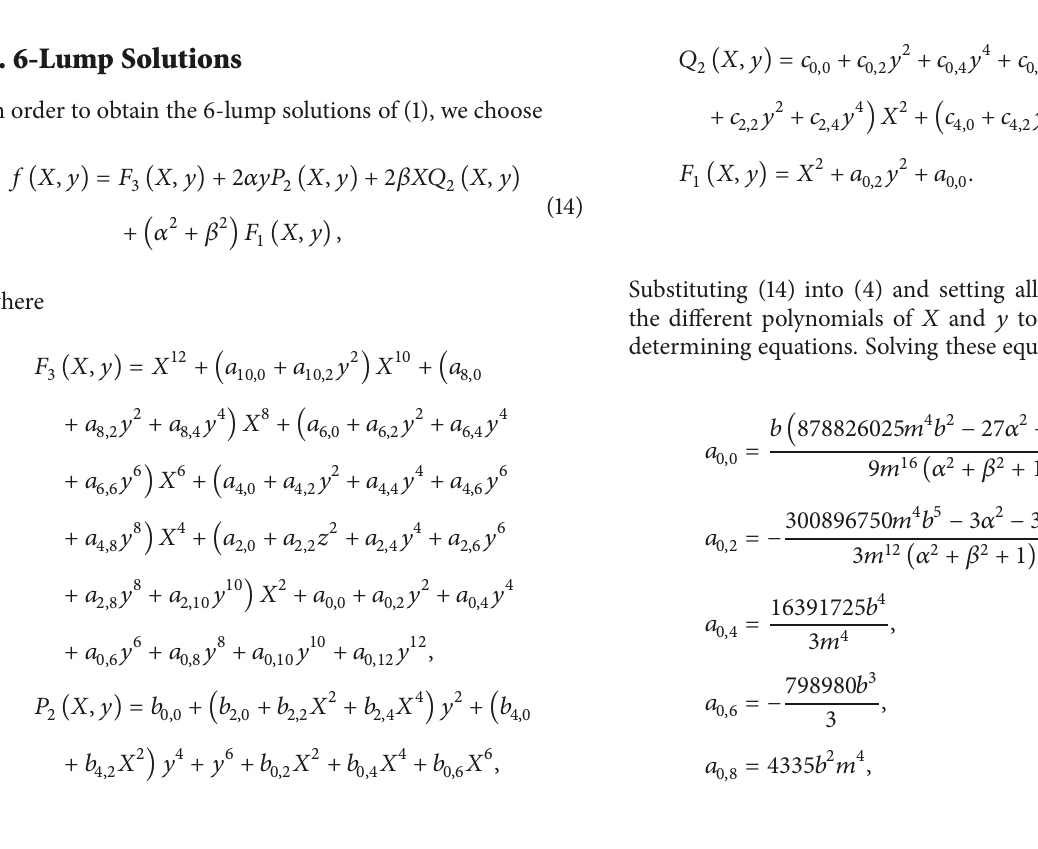
Figure 5: Plots (colored online) of 3-lump wave 𝑢 (13) with 𝑚 = 2, 𝑎 = 𝑏 = −2 , 𝑏 0,2 = 𝑐 2,0 = 1 , 𝛼 = 3000,𝛽 = 4000 . (a) Perspective view of the wave 𝑢(𝑥, 𝑦, 0) , (b) perspective view of the wave 𝑢(0,𝑦, 𝑡) , (c) perspective view of the wave 𝑢(𝑥,0, 𝑡) , (d) overhead view of the wave (a), (e) overhead view of the wave (b), and (f) overhead view of the wave